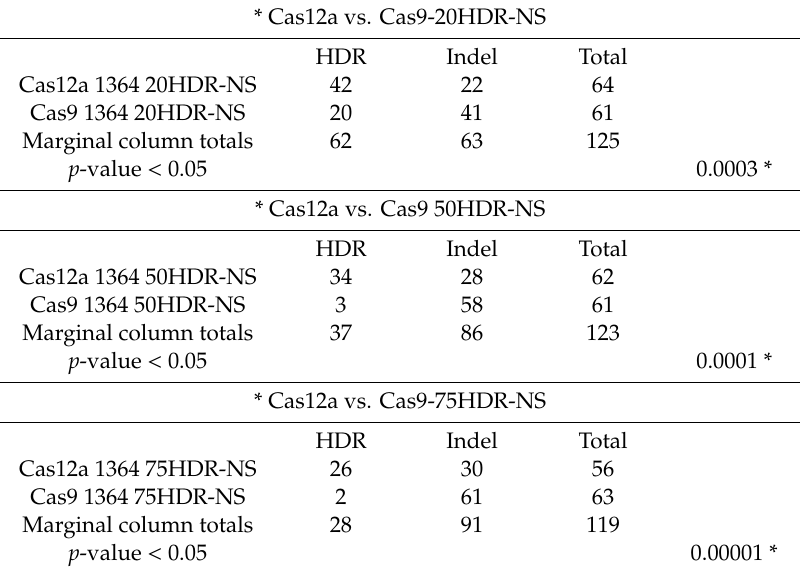
Table 1. Statistical comparison between CRISPR / Cas12a and CRISPR / Cas9 using homology arm lengths of 20, 50, and 75 bases. Fisher’s exact test was used to compare Cas12a with Cas9 using three di ff erent lengths of symmetrical homology arms. The total number of precise HDR events and Indels are presented along with the column totals and p -values < 0.05 for the three comparisons. p -values noted with * indicate statistically significant data within that